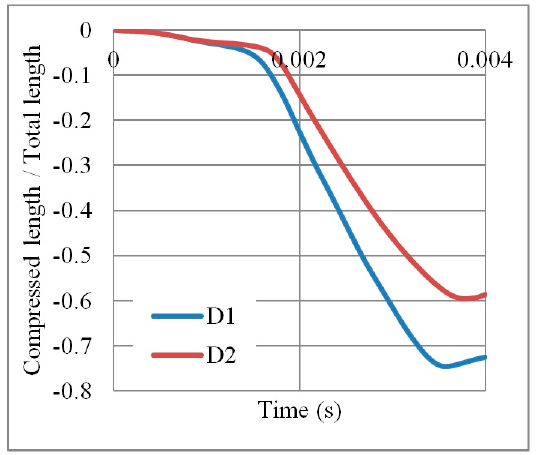
Figure 5. Ratio of compressed length to total length per time, for an auxetic core loaded in two different directions D1 and D2 ( t = 0.75 mm, L = 5 mm, t/L = 0.15, 𝜃 = 60°, AL2 grade).